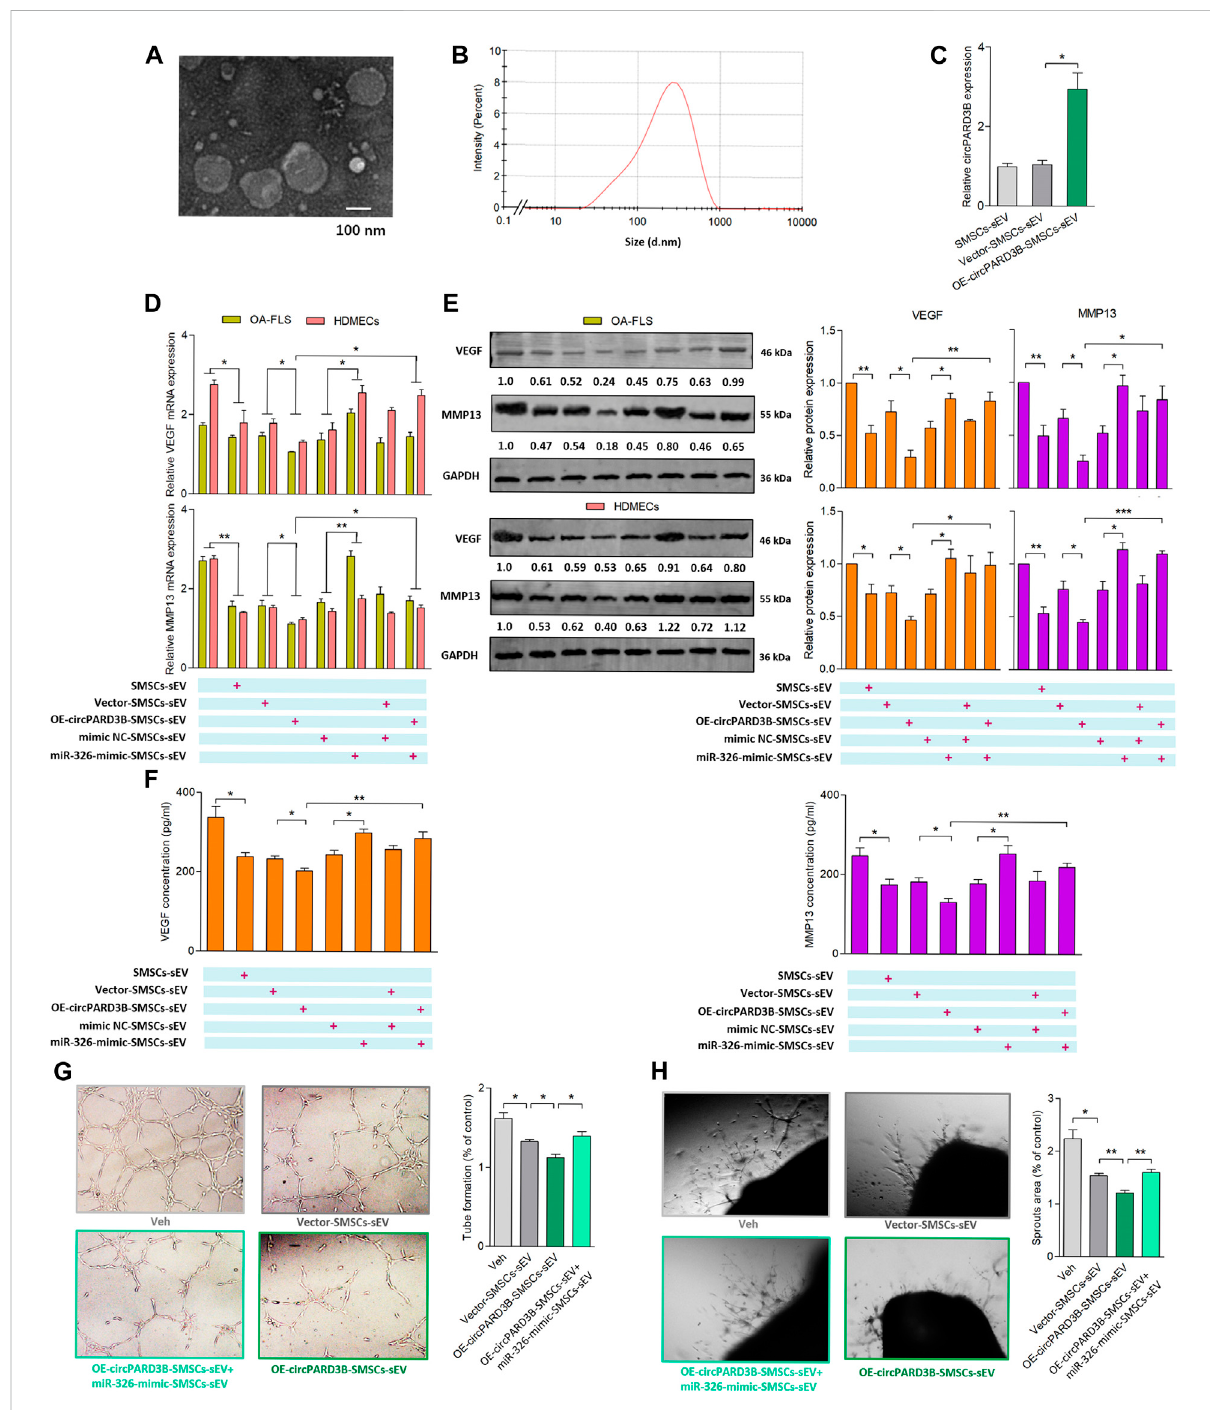
FIGURE 4 Evaluation of OE-circPARD3B-SMSCs-sEV ’ s anti-angiogenic effect on OA-FLS & HDMECs co-culture. SMSCs-sEV were con fi rmed by TEM (A) as well as DLS (B) as an average diameter of approximately 100 nm. mRNA (C,D) and protein (E) expression were respectively determined by qPCR and western blot analysis. (C) OE-circPARD3B-SMSCs-sEV carried enhanced expression of circPARD3B in contrast with those from Vector-SMSCs- sEV with statistical signi fi cance (n = 3). Under incubation of IL-1 β , VEGF/MMP13 mRNA (D) , as well as protein (E) expression in the OA-FLS and HDMECs co-culture and protein in the supernatants of the OA-FLS and HDMECs co-culture (F) were found to be downregulated by OE- circPARD3B-SMSCs-sEV, which was able to be inhibited by miR-326-mimic-SMSCs-sEV with statistical signi fi cance (n = 3). Changing trends